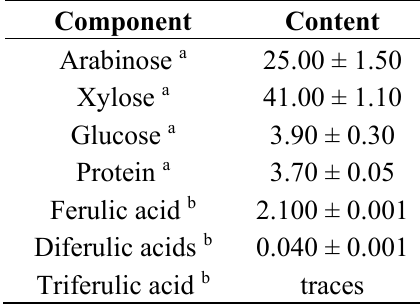
Table 1. Composition of water extractable